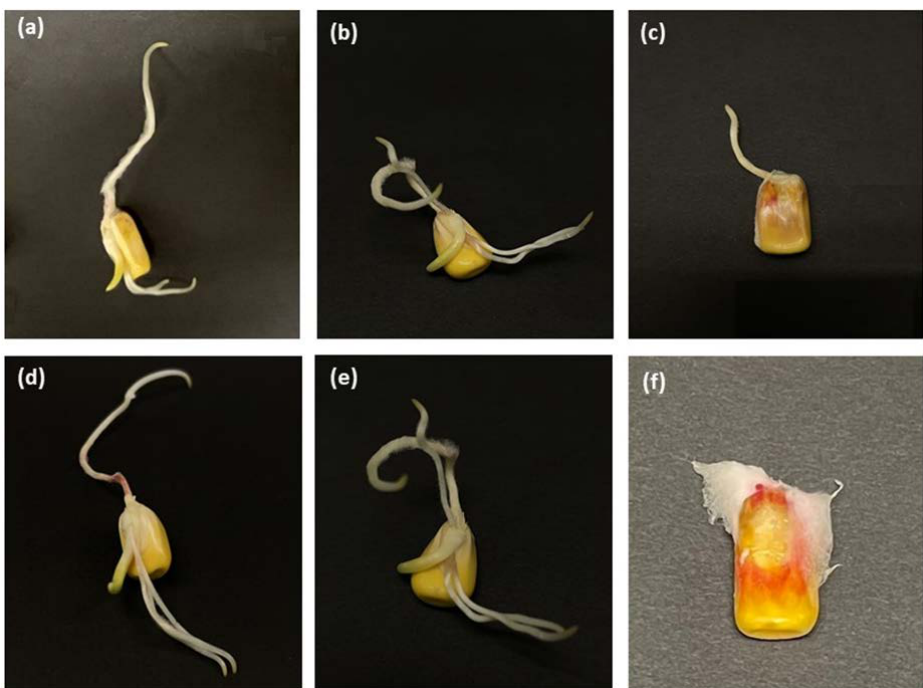
Figure 1. Pictures of maize kernels were magnified using a stereomicroscope (10×). Germinated kernel samples are for maize at 18, 21, and 24% moisture content stored for 21 days in non-hermetic ( a – c ) and hermetic ( d – f ) jars, respectively.